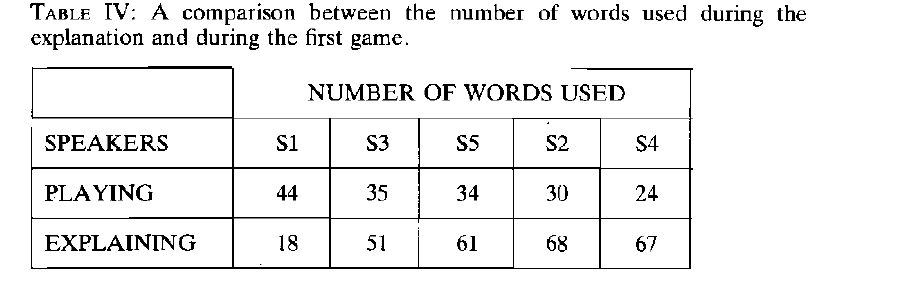
TABLE IV: A comparison between the number of words used during the explanation and during the first